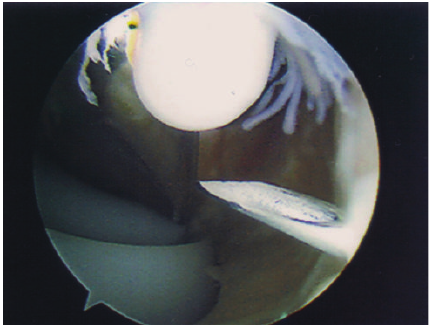
Figure 2: Arthroscopic view of lateral gutter showing fibrous tissue.